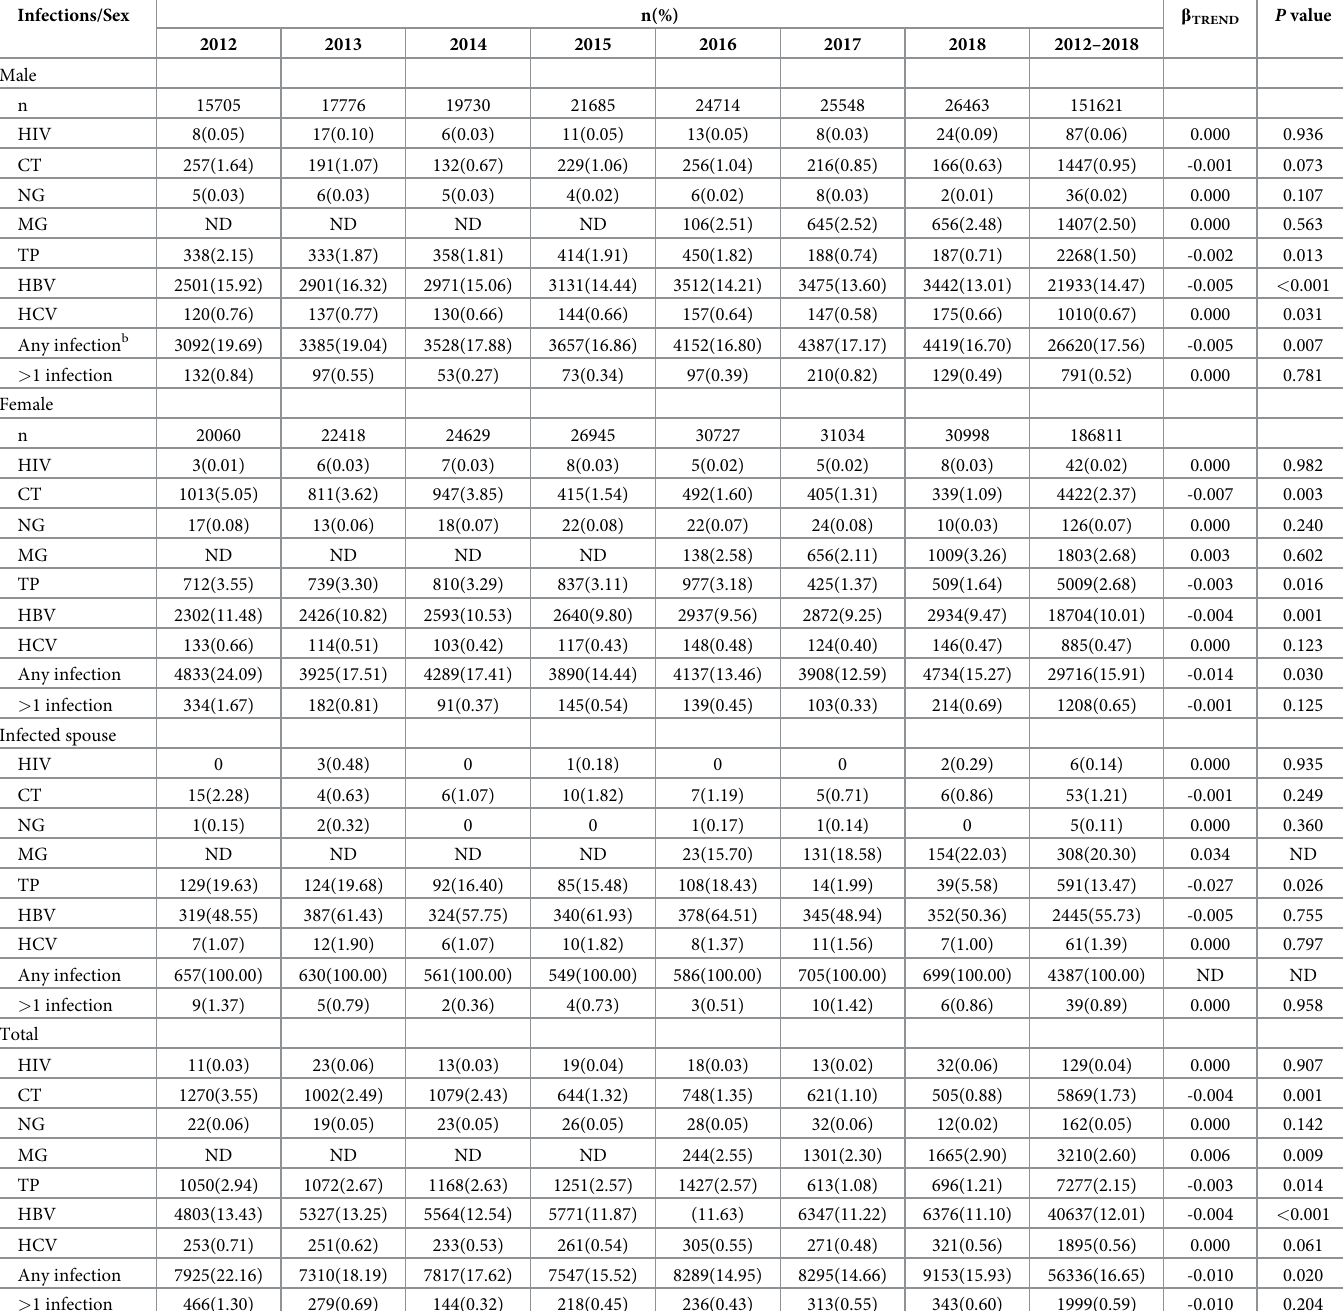
Table 2. Prevalence of HIV/other infections a among infertile population in China from 2012-2018. Infections/Sex β